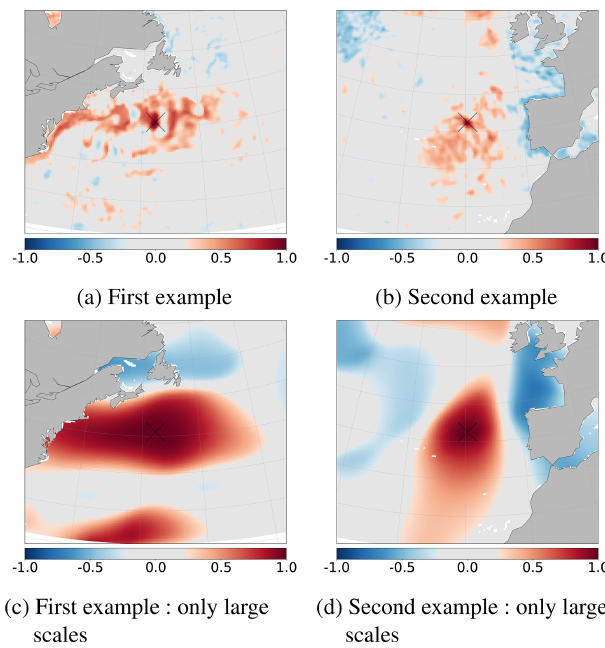
Figure 2. Two examples of ensemble correlation for the prior en- semble (SSH), according to two different reference points indicated by black crosses, computed for the full spectrum (a, b) and for the large scales ( c, d , l ∈ [0 ; l c ], with l c = 34 following Eqs. 2 and 3, which corresponds to a characteristic scale larger than L ≈ 187km). Light grey colour corresponds to non-significant values of ensem- ble correlations for an ensemble of N = 69 members (smaller in absolute value than 0 . 2367 with significance threshold at